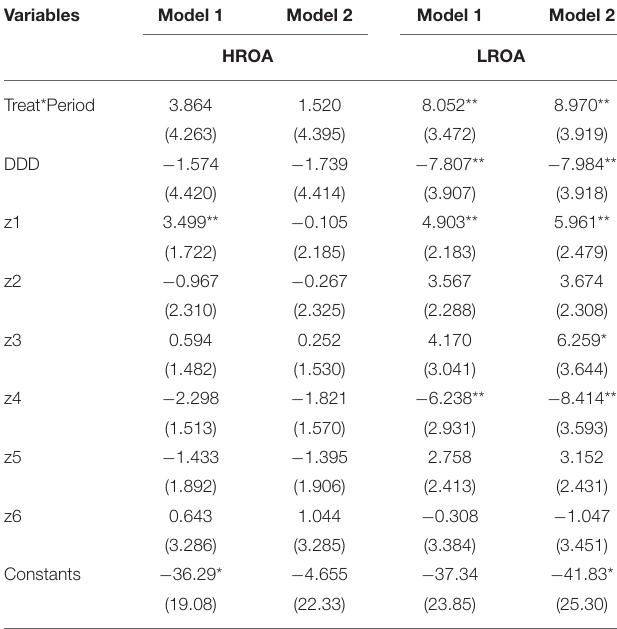
TABLE 10 | DDD regression results of enterprise